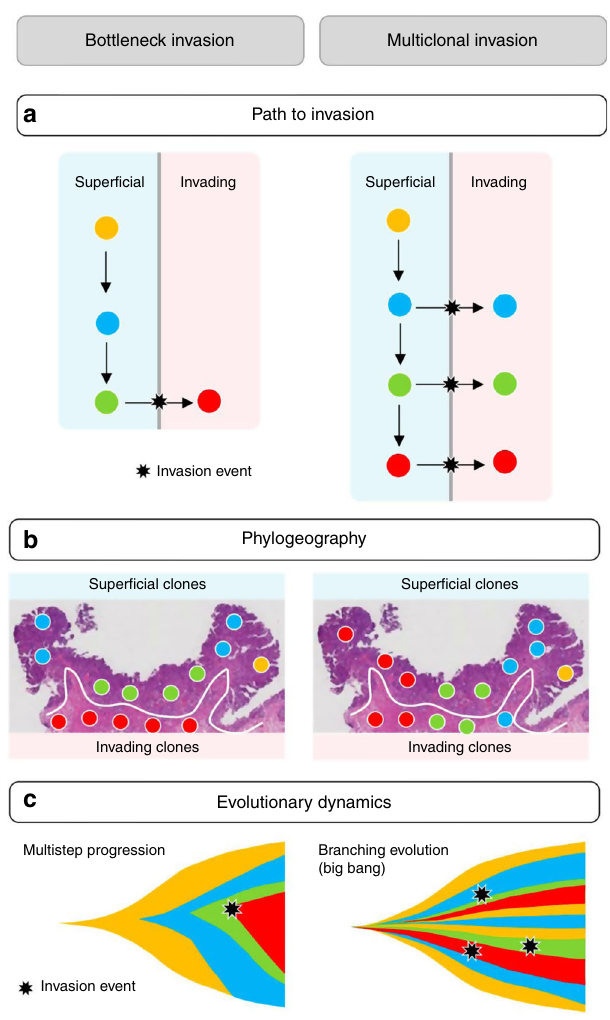
Fig. 1 Bottleneck vs Multiclonal Invasion. Topographic and phenotypic subclone distributions generally differ between the bottleneck (left) and multiclonal invasion (right) models. a In the bottleneck model (left), the tumor evolves in super fi cial regions and invasion constitutes an evolutionary bottleneck where only the more advanced subclones eventually invade the stroma. In the multiclonal invasion scenario (right), co-existing subclones have a similar malignant potential to invade the stroma. b Left: if growth occurs through bottlenecks, subclones should be arranged horizontally with respect to phenotype, with a smaller number of more advanced subclones (red) with invasive phenotypes. Right: under multiclonal invasion, subclones have similar malignant potential; expansile growth occurs radially in all directions resulting in vertical subclones columns with both super fi cial and invasive phenotypes in the fi nal tumor. c Left: the bottleneck model is compatible with the classic multi-step progression of cancer evolution whereby the invasive clone arises late (star). Right: the multiclonal invasion scenario is compatible with branching evolutionary models with multiple co-evolving subclones, such as predicted by the Big Bang